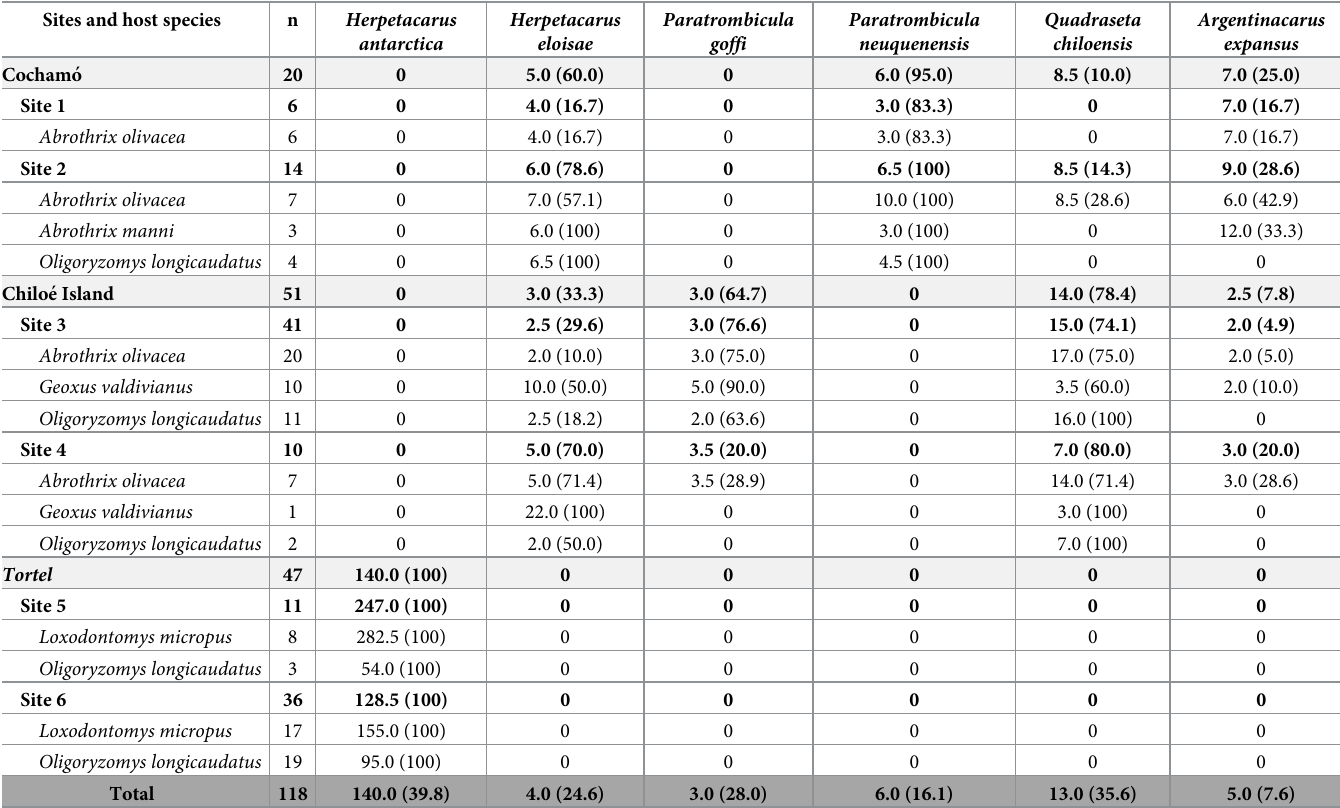
Table 2. Median abundance of chiggers of different species from wild rodents. In parenthesis is the percentage of rodents parasitized by the respective mite species. Sites and host species